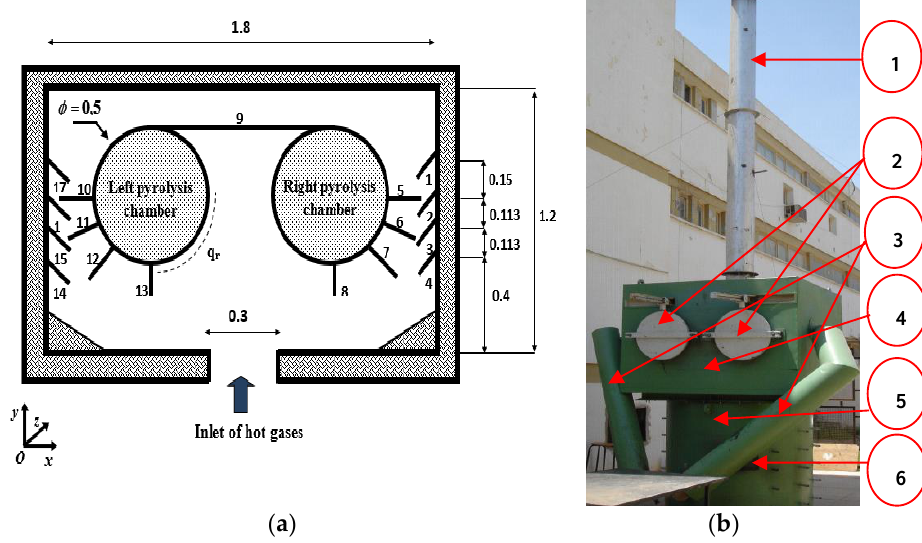
Figure 4. ( a ) Geometrical characteristics of the heat recuperator projected in z -plane, ( b ) Pilot plan. 1. Chimney. 2. Pyrolysis chambers. 3. Pyrolysis gases channels. 4. Heat exchanger. 5. Pyrolysis gases combustor. 6. Pyrolysis gases and air combustor inlet.